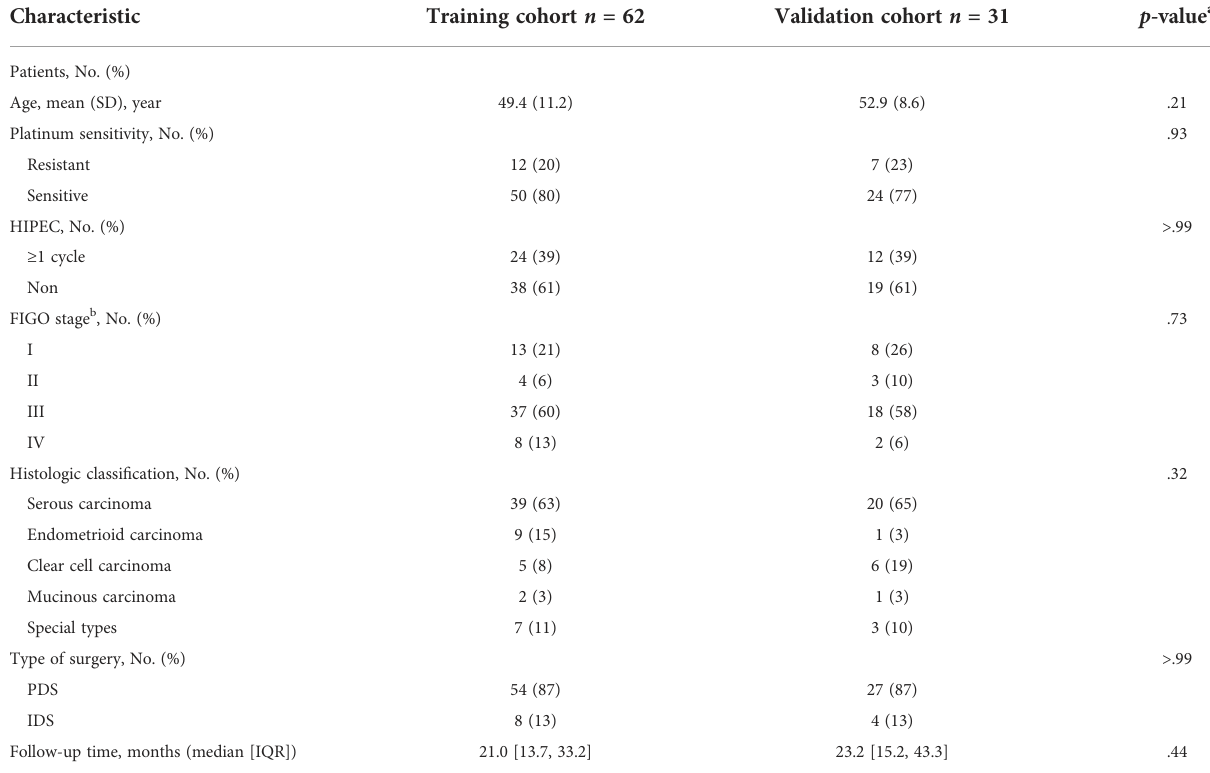
TABLE 1 Characteristics of patients in the training and validation cohorts.